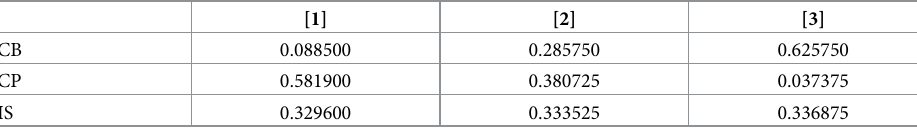
Table 5. Rank probabilities of fixation methods for KT-1000 assessment.